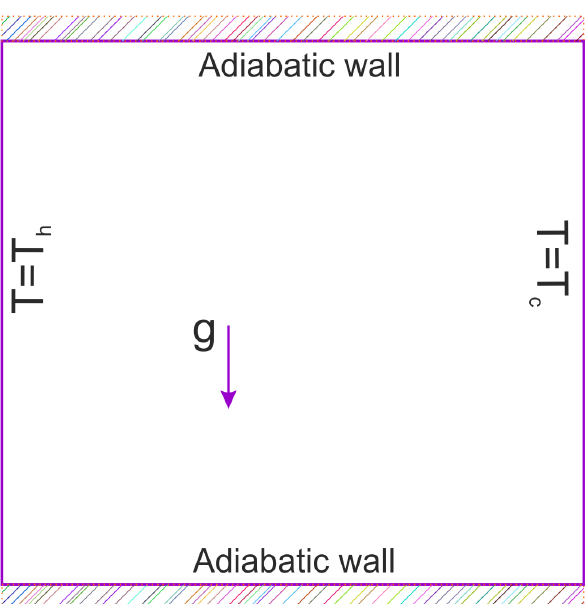
Figure 1: Statement of the problem about the free convection of a